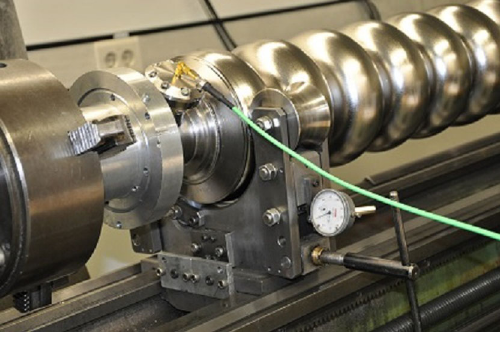
FIG. 35. Radial tuning of the cavity